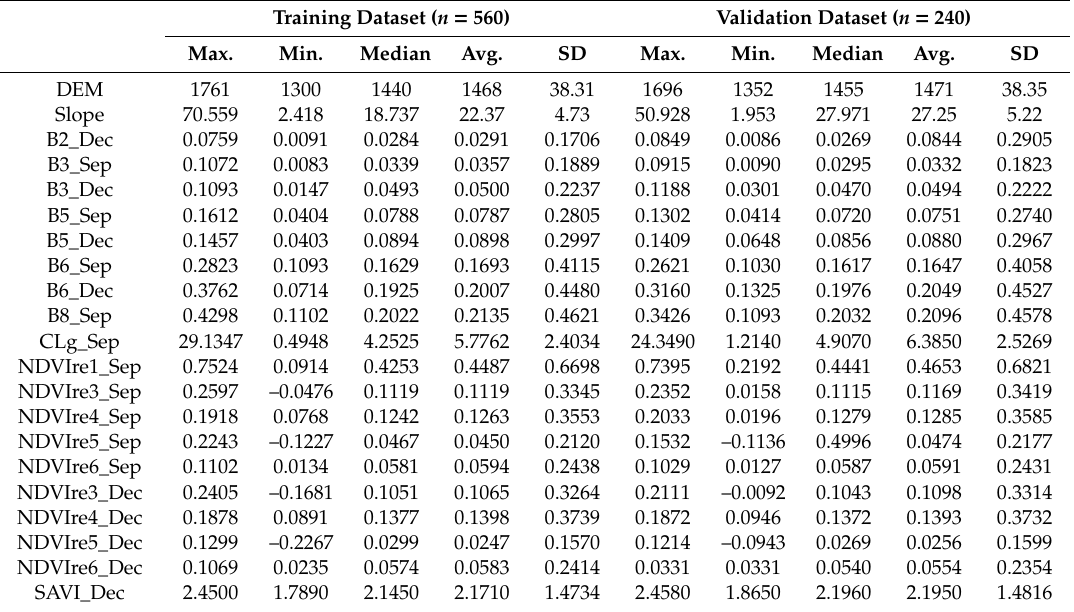
Table 3. Descriptive statistics of the training and validation datasets from the pixels sampled at the fifth taxonomic